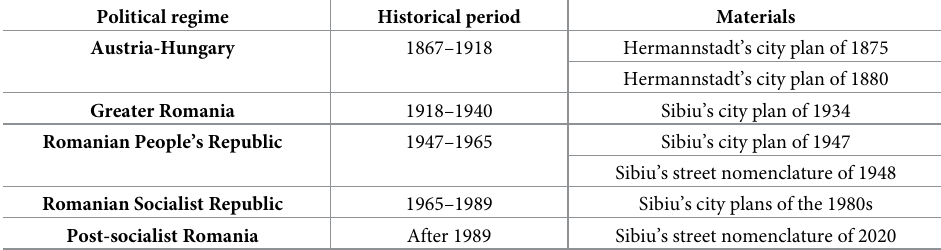
Table 1. Historical sampling and empirical